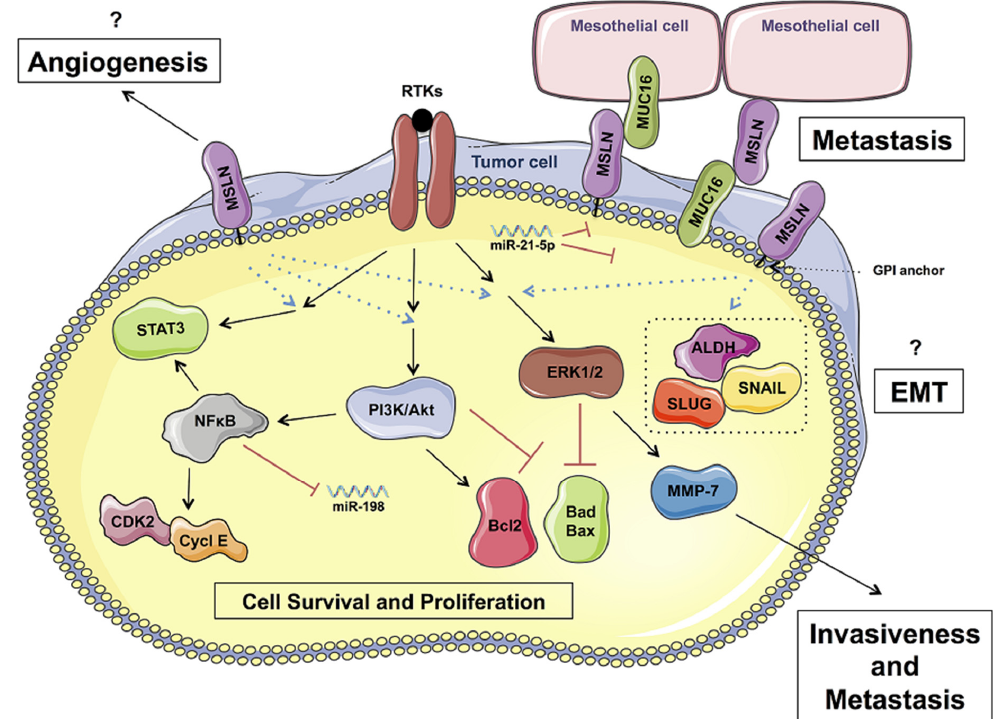
Figure 1. Putative roles of MSLN in PDAC progression. MSLN promotes tumor cell survival and proliferation through ERK and PI3K/Akt pathways; and invasiveness and metastasis processes by MMP ‐ 7 activity. Metastasis could also be facilitated by interaction with MUC16 expressing